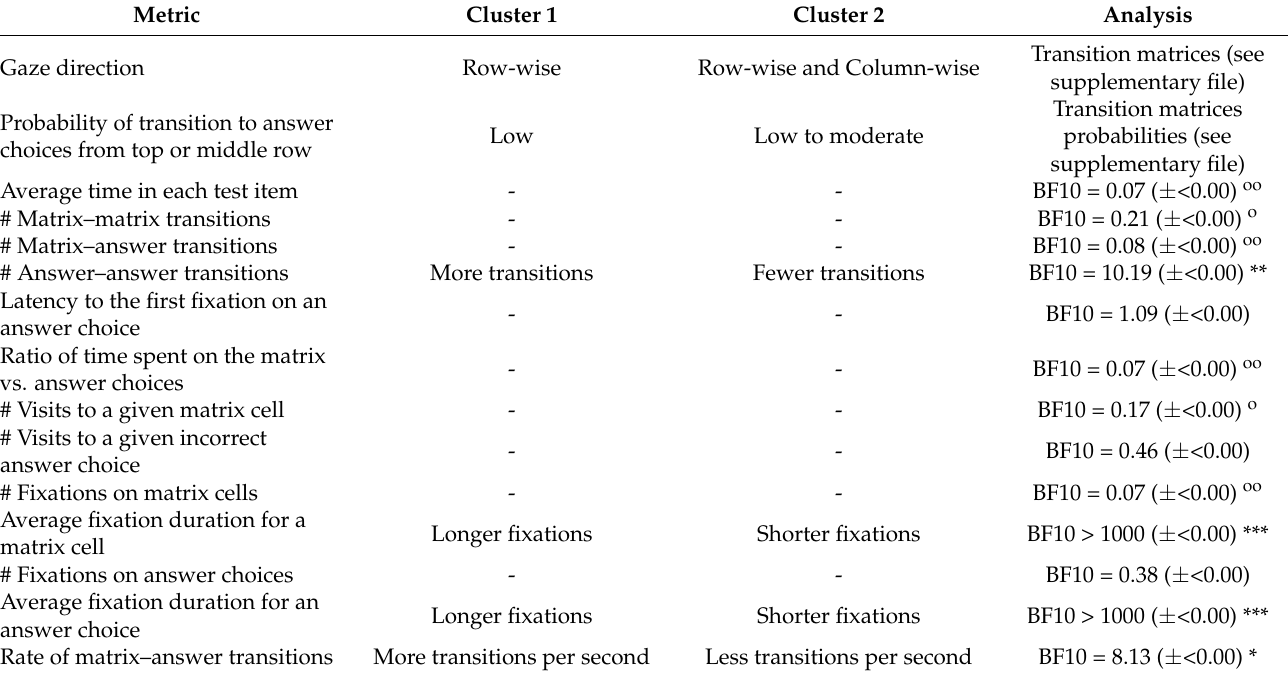
Table 2. Comparison of the model-based clusters of eye movements. The comparison was conducted based on the transition matrices or the Bayes Factor for each cluster.